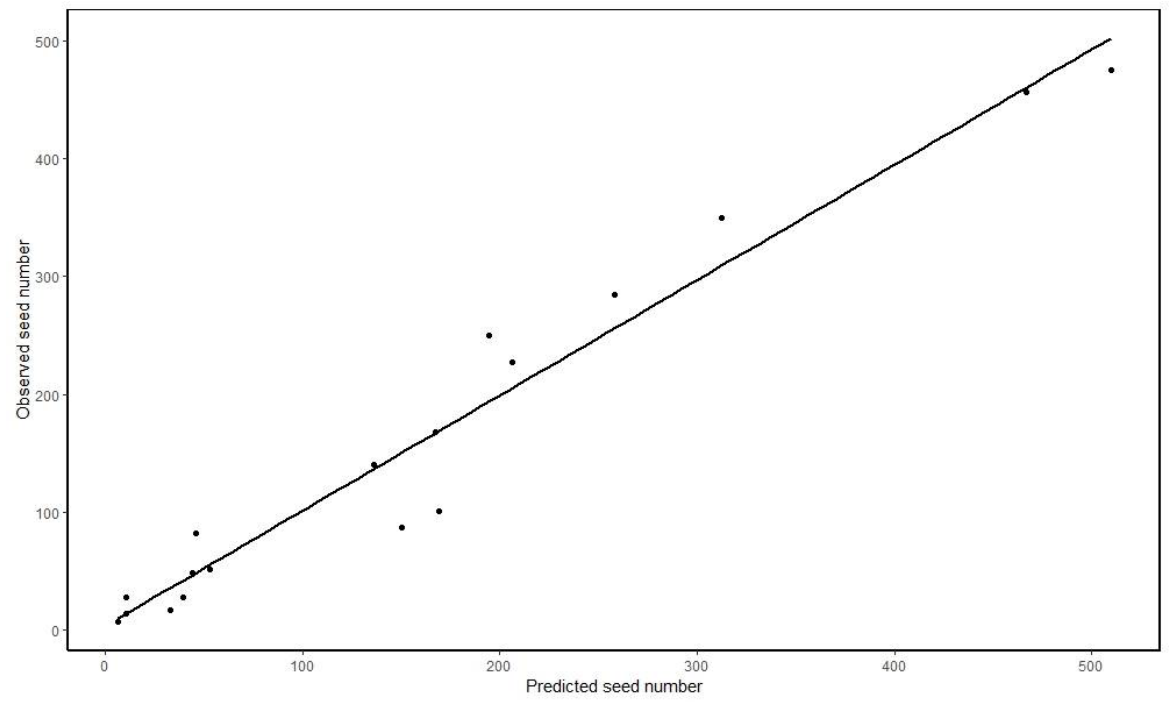
Figure 3. Number of seeds captured by all seed traps vs predicted number of seeds by the best model.